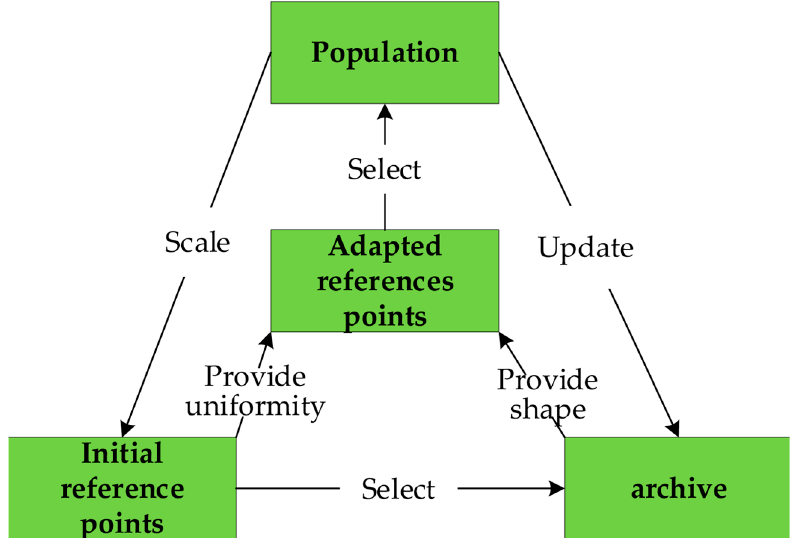
Figure 2. The relationship between the four solution sets. (2) NSGA-II